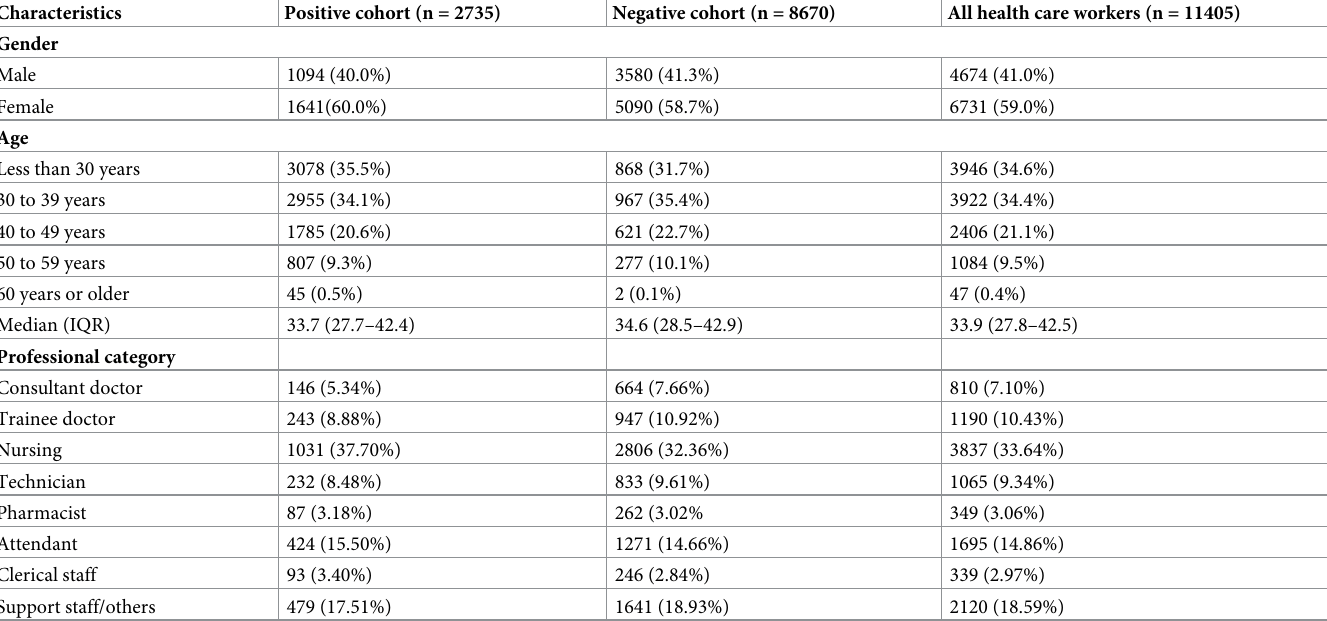
Table 1. Demographic details of the health care workers cohorted based on COVID results.